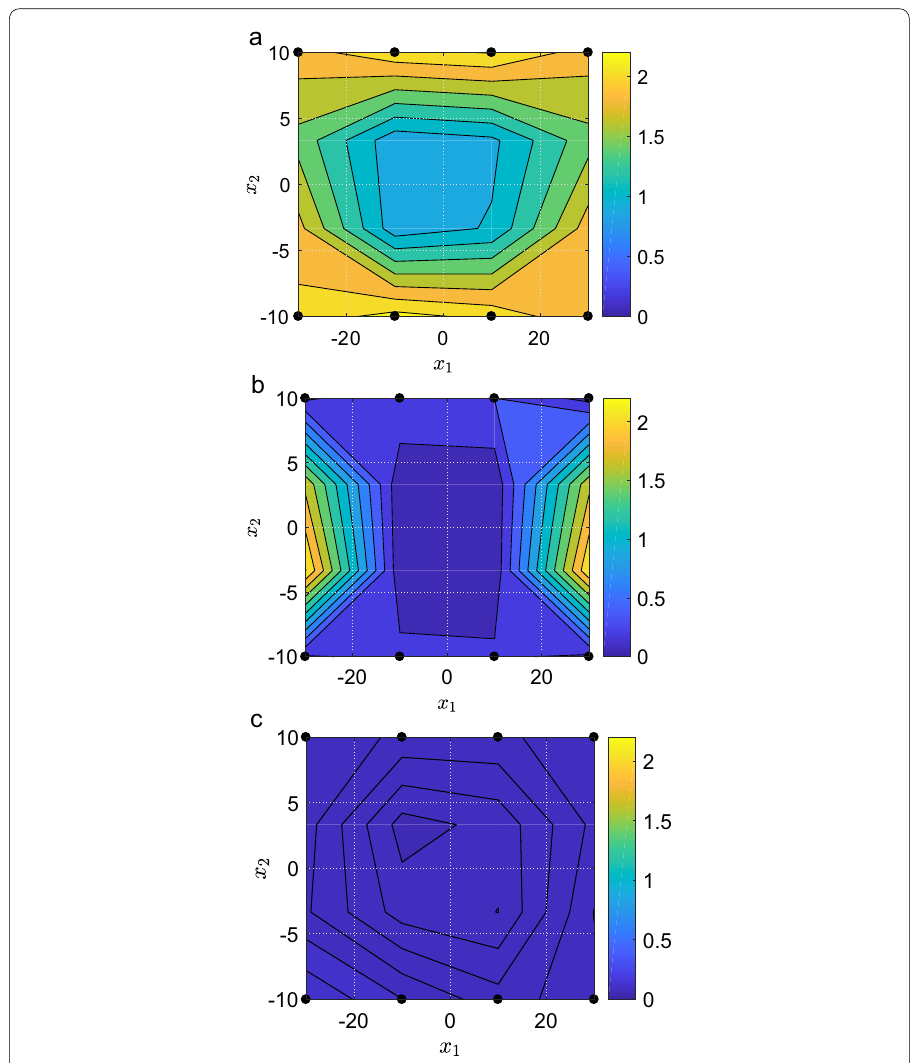
Fig. 4 Performance in T oa across space. Root-mean square error in (m) with respect to different locations x 0 . Results based on 50 Monte Carlo runs. a Corresponds to to the standard E rm (8), b corresponds to the proposed method (12) and c refers to the robust MM-algorithm called Huber regression in